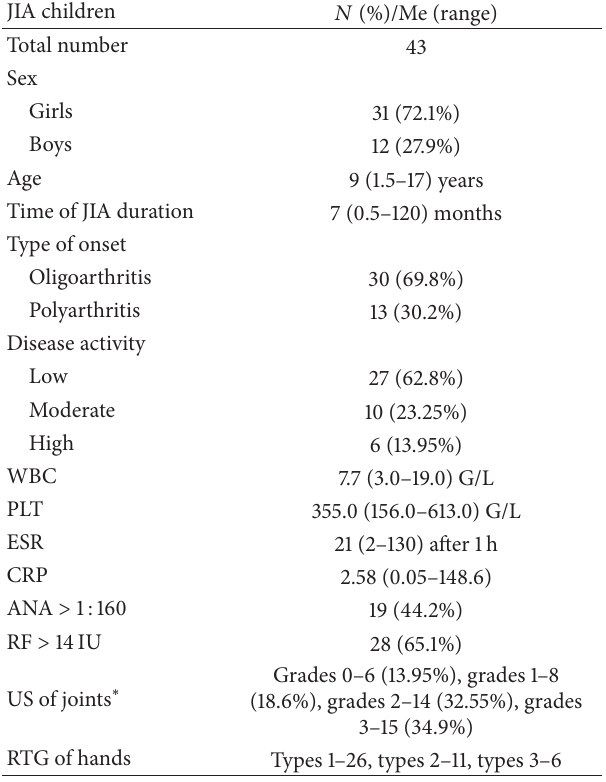
Table 1: Characteristics of the examined